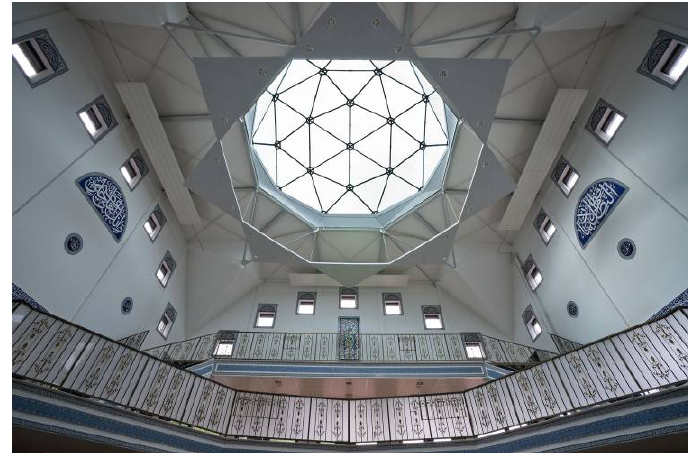
Figure 13: Interior view of the finished mosque and dome (Photo: Berend van der